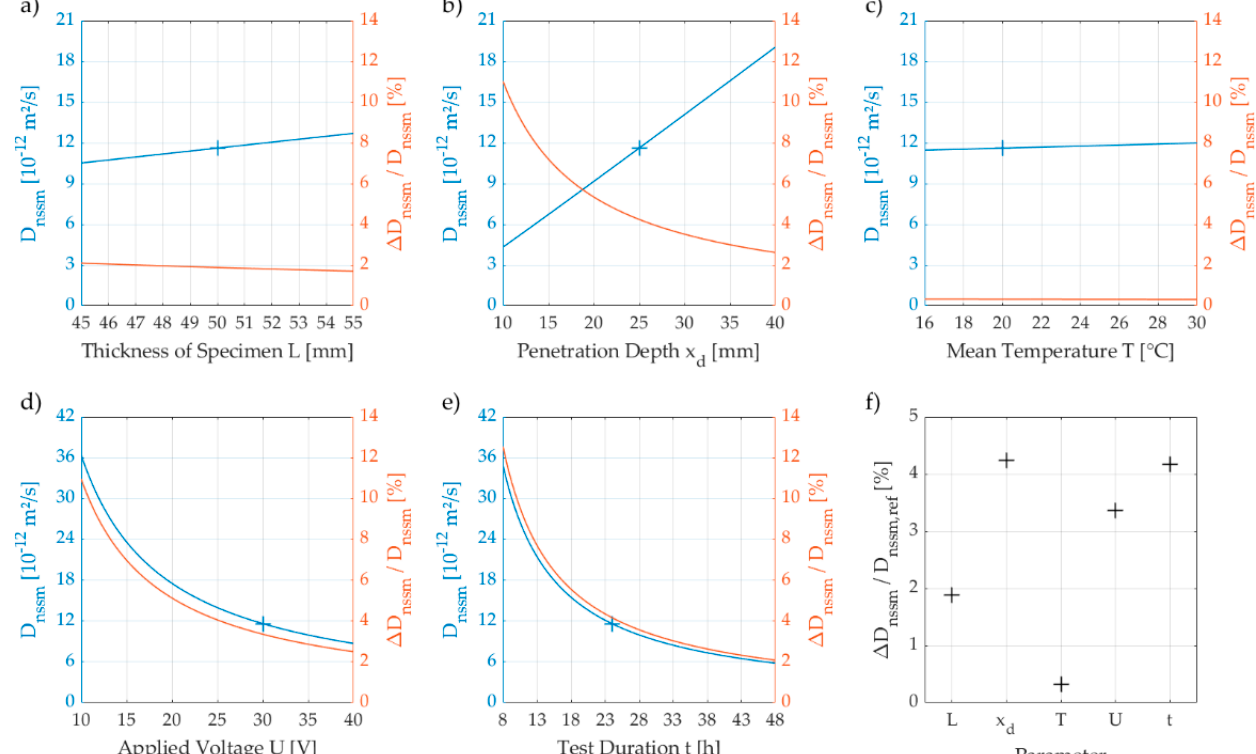
Figure 3. Simplified sensitivity analysis of the non-steady-state chloride migration coefficient D nssm to variations in the thickness of specimen a ), the penetration depth b ), the mean temperature of the solution c ), the applied voltage d ) and the duration of testing e ). Blue colour refers to the measured D nssm -values, red colour to the relative deviation Δ Dnssm /D nssm , that illustrates the impact of small variations (1 part per unit) of each parameter on the D nssm -value. The crosses indicate the reference value D nssm,ref . Panel f ) displays the relative deviations observed for the reference parameters.